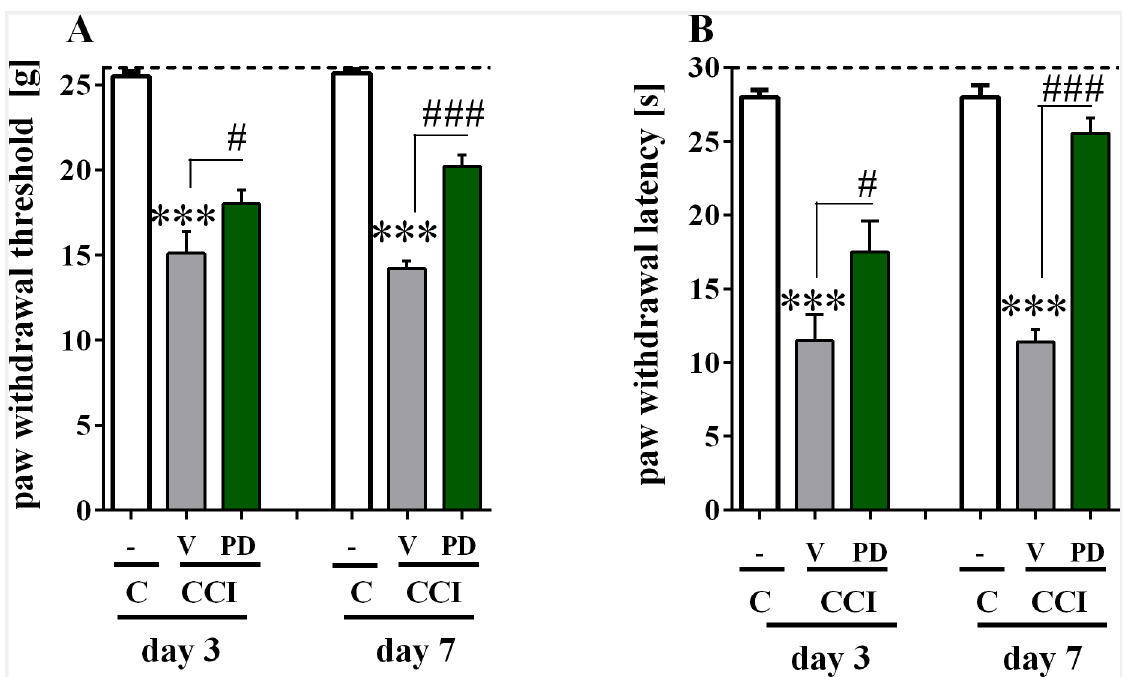
Fig 1. Effect of PD98059 on the development of neuropathic pain symptoms. Effect of PD98059 (2.5 mcg/5 mcl; i . t .; 16 h and 1 h before CCI and then once daily for 7 days) on the development of mechanical allodynia (A; von Frey test) and thermal hyperalgesia (B; cold plate) on days 3 and 7 after CCI. Pain was assessed using von Frey and cold plate tests 30 min after the last drug administration, and the data are presented as the means ± SEM. The inter-group differences were analyzed with ANOVA and Bonferroni ’ s multiple comparison test. *** p < 0.001 indicates a significant difference compared to the control group (C), and # p < 0.05 or ### p < 0.001 indicates a significant difference compared to the V-CCI rats (ANOVA, Bonferroni ’ s test). The number of animals per group — day 3: C n = 7; V-CCI n = 7; PD-CCI n = 10; day 7: C n = 17; V-CCI n = 28; PD-CCI n = 26. C, control,; V, vehicle, PD, PD98059. The a line is drawn at value that represents the